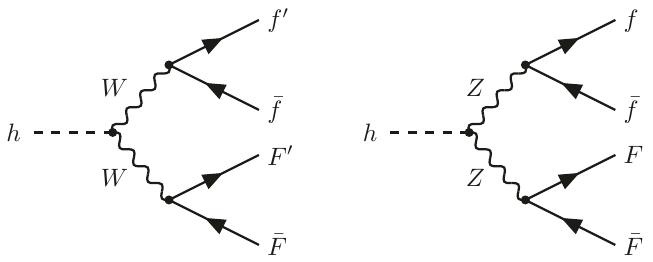
Figure 5 . Charged- and neutral-current LO diagrams contributing to the process h ! 4 f . The primed fermions f 0 and F 0 stand for the isospin partners of f and F , respectively. For F = f 0 in the (cid:12)nal state, both contributions must be taken into account. For F = f the neutral-current diagram on the right-hand side appears in a second version with the f and F lines (or the (cid:22) f and (cid:22) F lines)